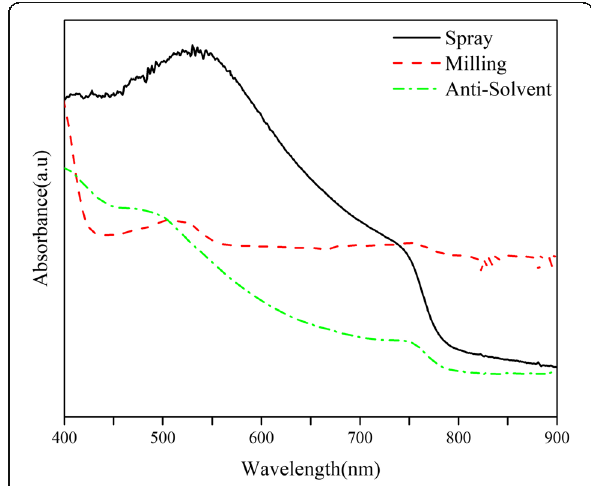
Fig. 7 UV-Vis absorbance of the perovskite films prepared from the paste of the produced powders